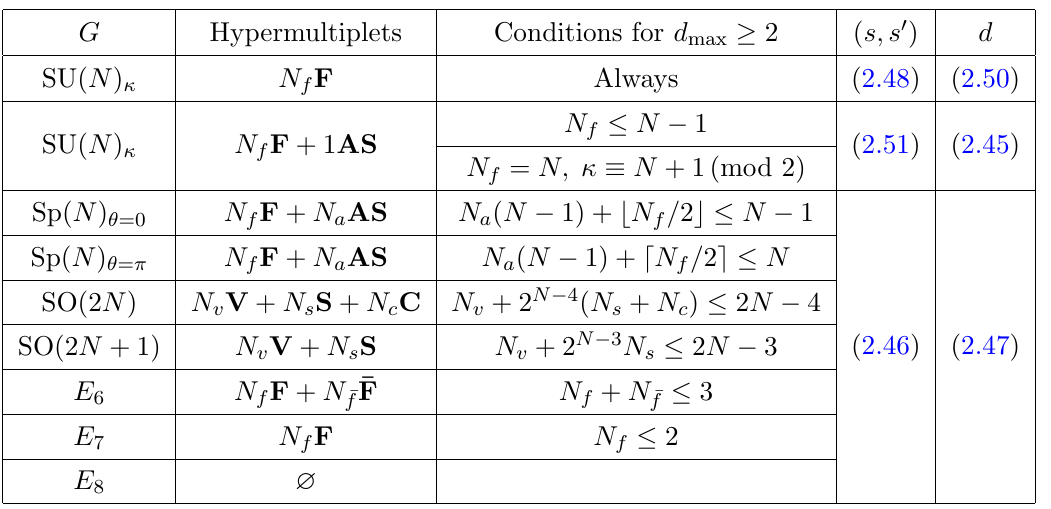
Table 1 . List of 5d gauge theories whose partition function is determined via the blowup equations. The number of hypermultiplets are bounded so that there are at least 3 blowup equations. For the case of SU( N ) + N f F theory, it turns out that the Young diagram formula (3.1) always satisfy at least 3 blowup equations. When N f + 2 j (cid:20) j > 2 N , however, this formula does not produce the correct partition function for the UV (cid:12)eld theory as we discuss in the